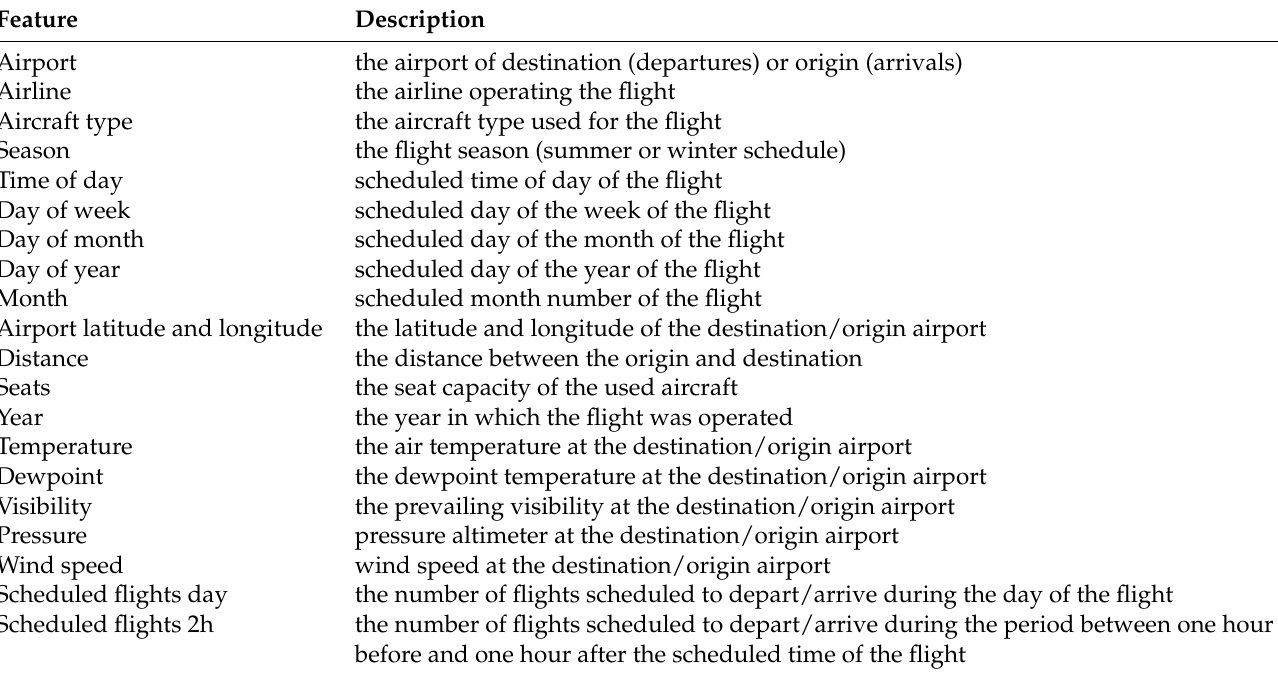
Table 2. Description of features selected for flight delay